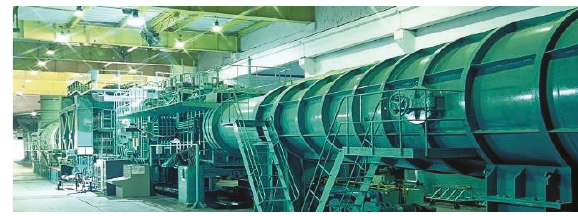
Figure 2: Pneumatic pressure equipment in China Aerodynamics Research & Development